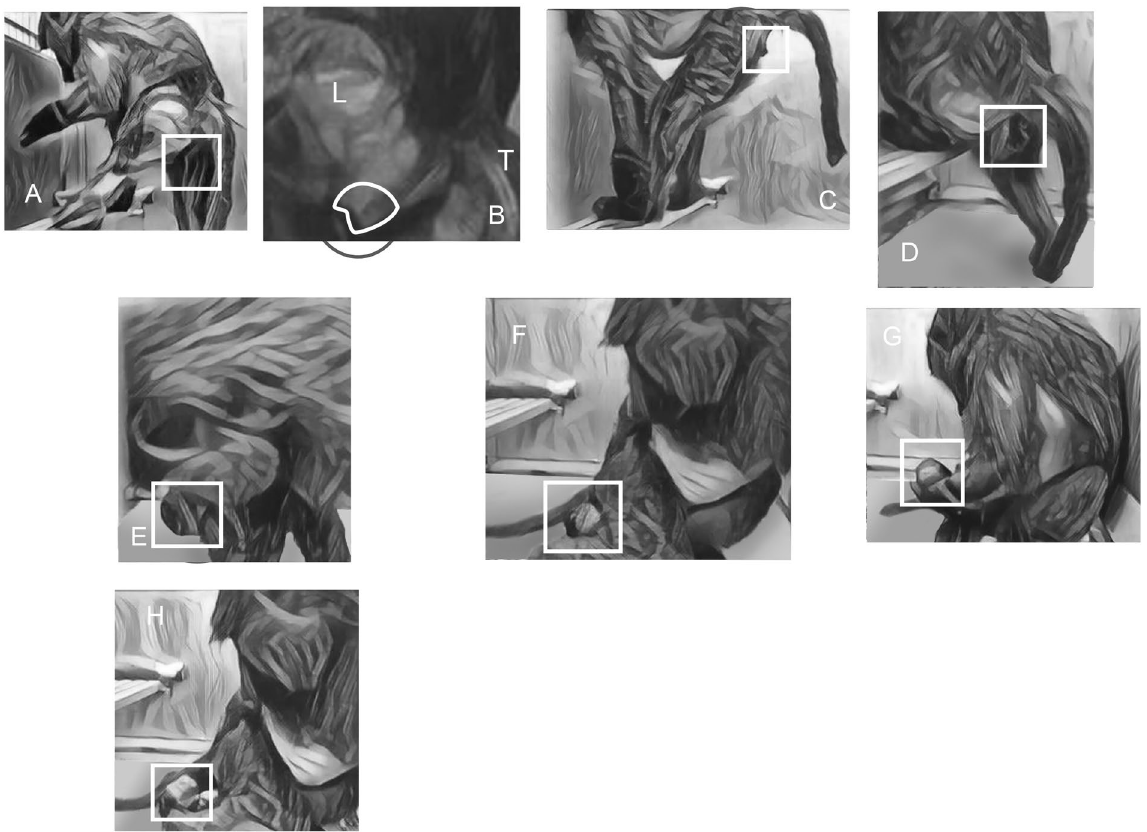
Figure 1. ( A ) initial brief pushing efforts, ( B ) the snout is visible through the introitus, ( C ) the presented part of the fetus did not stay on the perineum at the introitus between expulsive efforts, ( D ) snout fixation, ( E – G ) External head rotations, ( H ) fetus is born in prone anterior